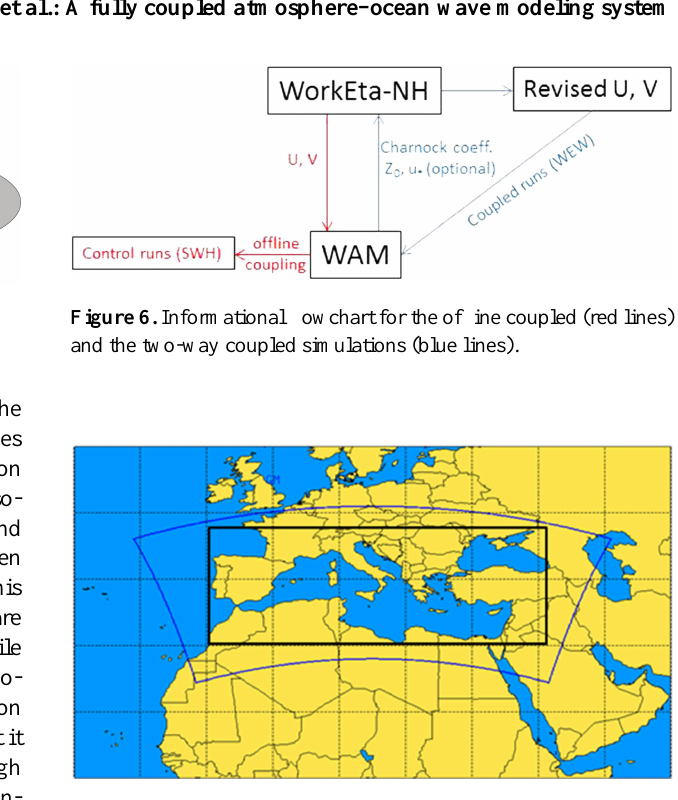
Figure 7. Current domain configurations of the atmospheric (blue line) and the ocean wave models (black